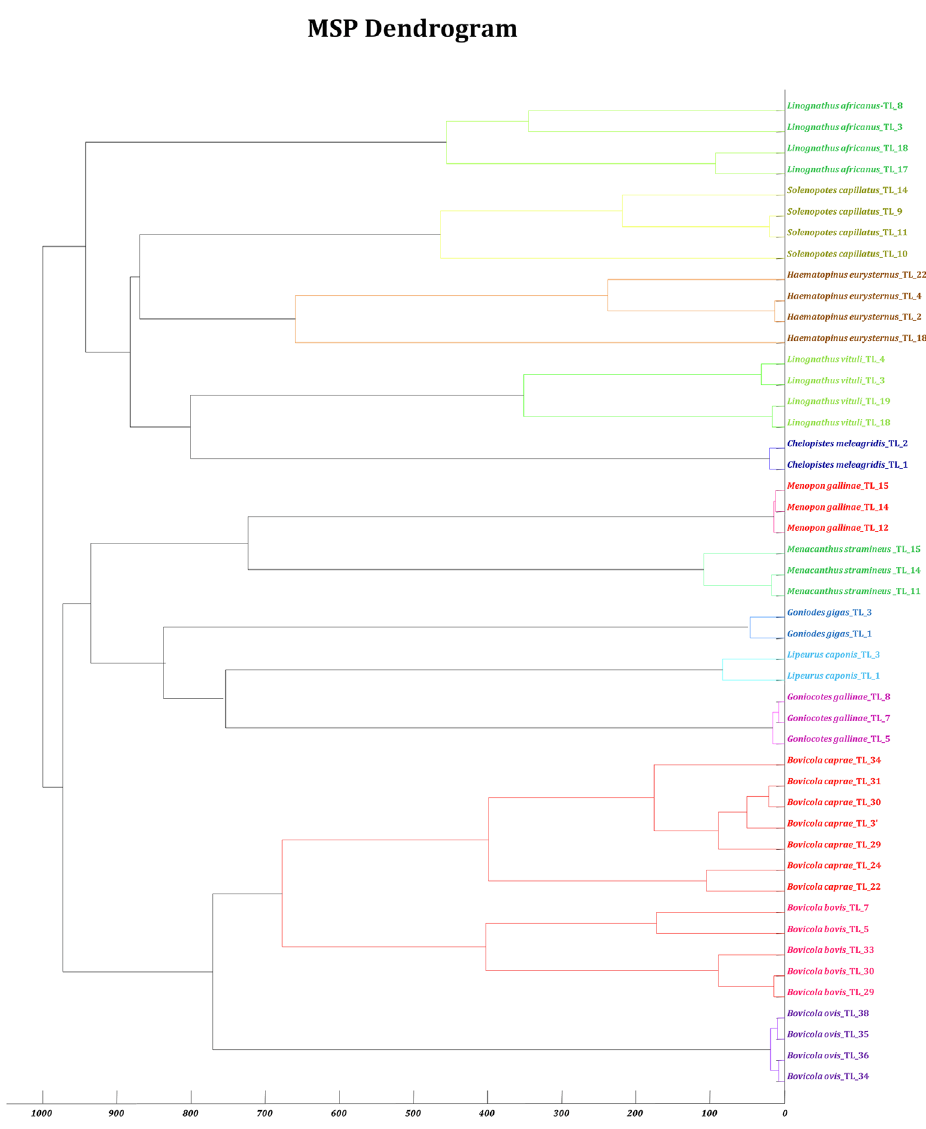
Figure 6. Dendrogram constructed using MALDI-Biotyper software v.3.3 including 2 – 7 random MS spectra representative of the 13 distinct species of